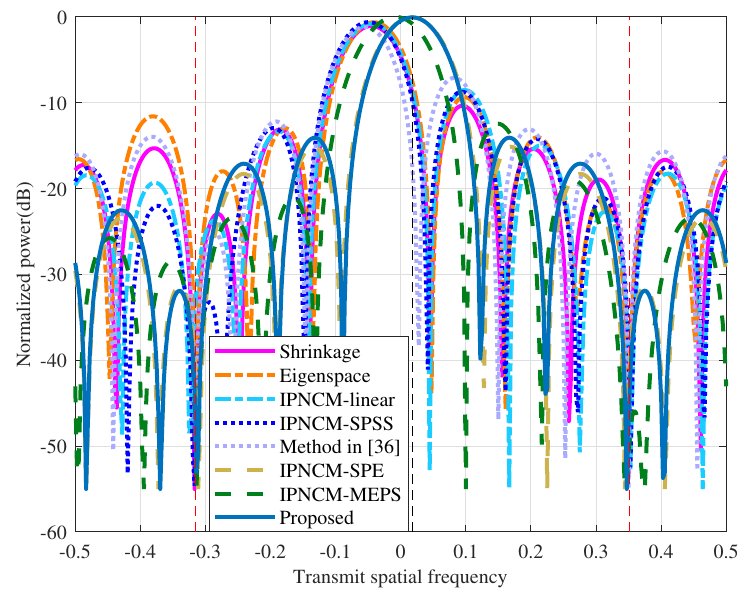
Figure 7. Beam patterns of the tested beamformers in the transmit spatial frequency.